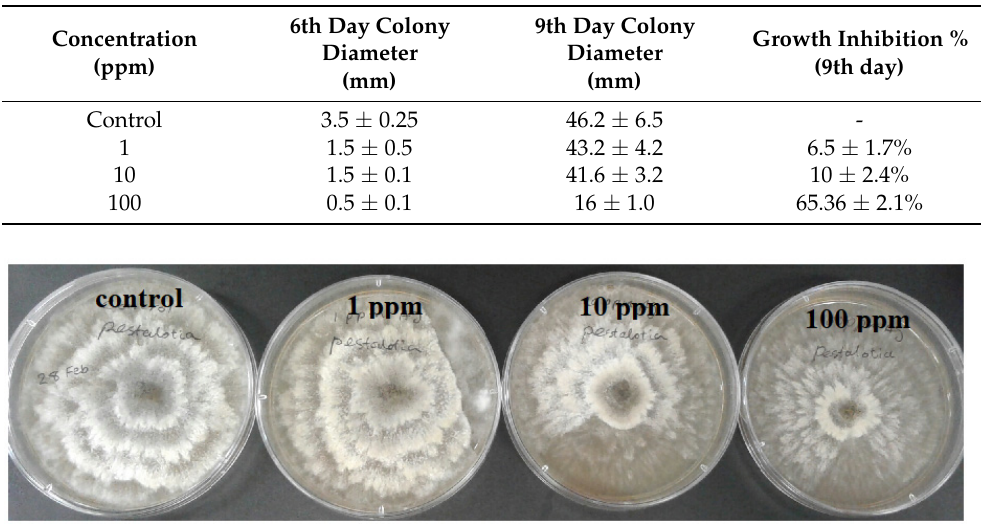
Table 2. Growth of P. concavum (colony diameter in mm) treated with different concentrations of the biogenic Ag NPs for 9 days. Data are presented as mean ± SD of three replications.